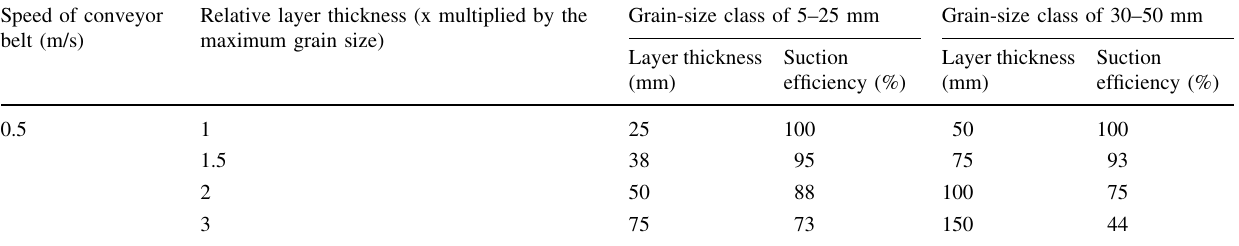
Table 4 Suction efficiency of the feed material in different grain-size classes Speed of conveyor Relative layer thickness (x multiplied by the belt (m/s) maximum grain size)